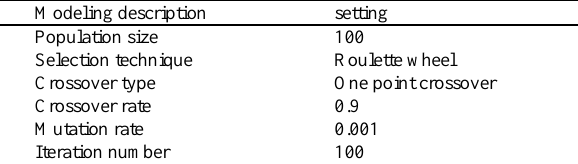
Table 1. Genetic Algorithm (GA) parameters setup . Modeling